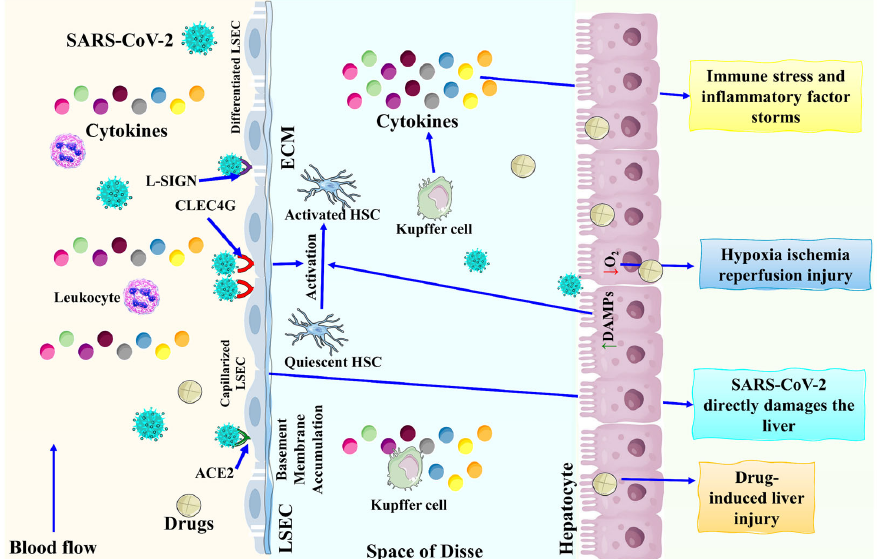
Figure 1. Mechanism of action of SARS ‐ CoV ‐ 2 related liver damage. LSEC: Liver sinusoidal endo ‐ thelial cells; L ‐ SIGN: Liver/lymph node ‐ specific intercellular adhesion molecule ‐ 3 ‐ grabbing integ ‐ rin; CLEC4G: C ‐ type lectin domain family 4 member G; DAMP: Danger ‐ associated molecular pat ‐ lial cells; L-SIGN: Liver/lymph node-specific intercellular adhesion molecule-3-grabbing integrin; CLEC4G: C-type lectin domain family 4 member G; DAMP: Danger-associated molecular